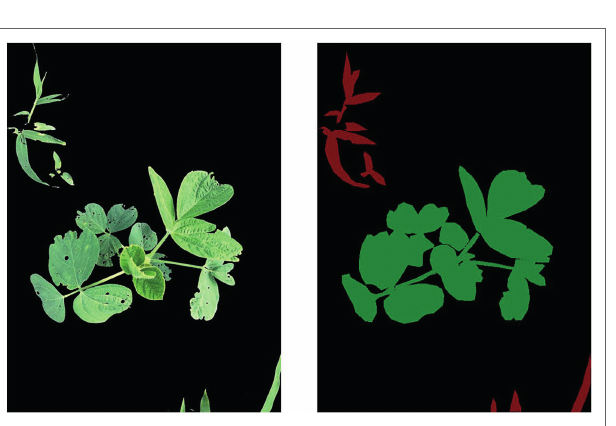
FIGURE 2 | Original image